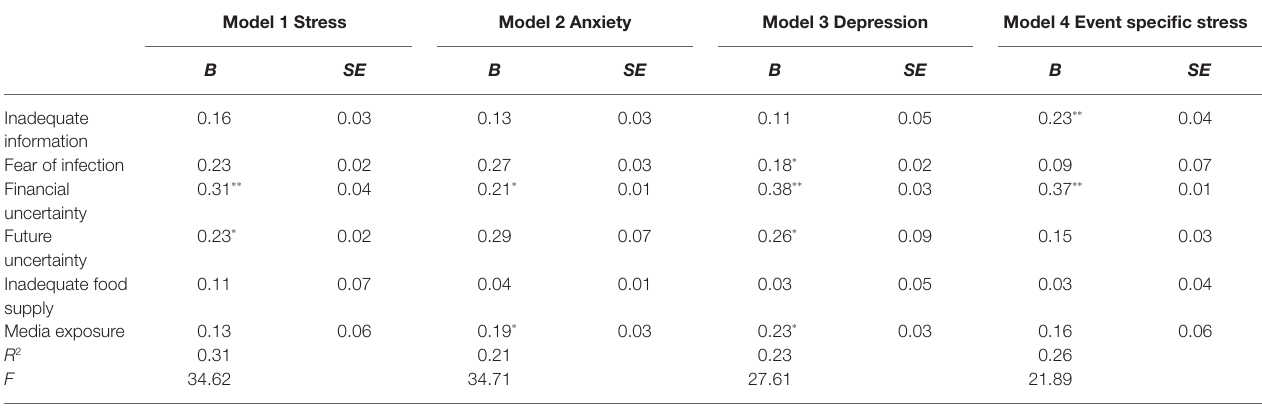
TABLE 4 | Connexion between COVID-19 specific social stressors and psychological well-being and mental health of